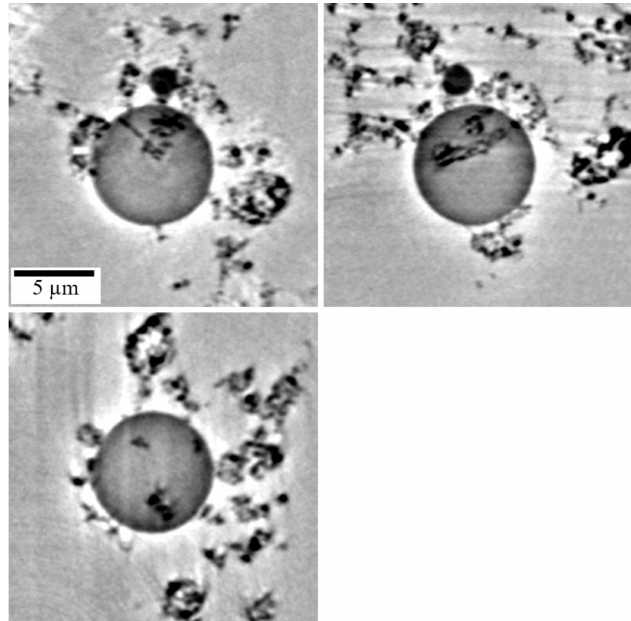
Figure 7 Orthogonal-cut images of the 3D volume rendered image in Fig. 6( a ) without binarization. The water droplet appears as a circle in the center of each cross-sectional image. The water droplet includes hydrophobic solid